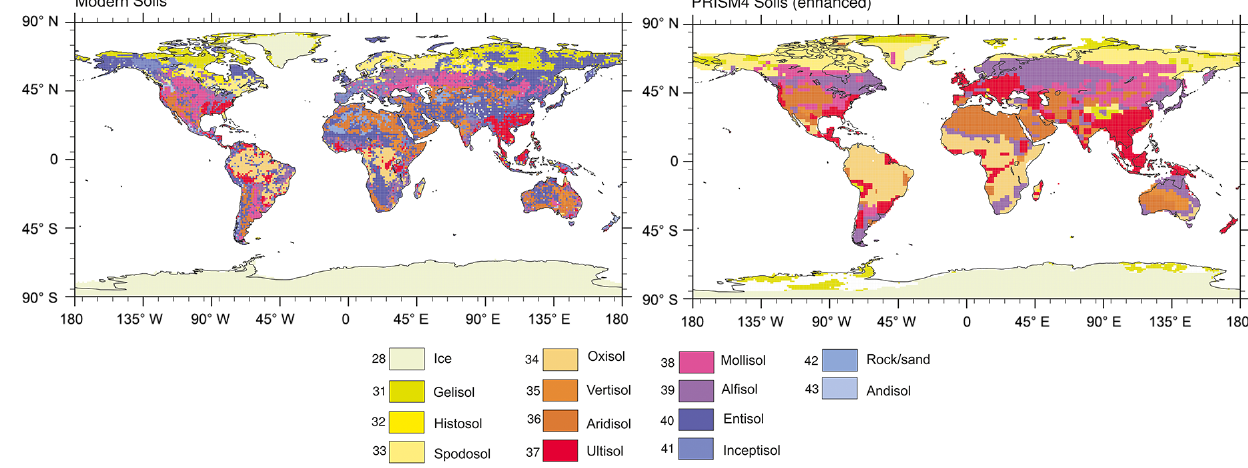
Figure 6. Pound et al. (2014) data set of global modern and Pliocene soil types (shown on the enhanced PlioMIP2 land–sea mask). Modern data are based upon the FAO/UNESCO modern soil map (Version